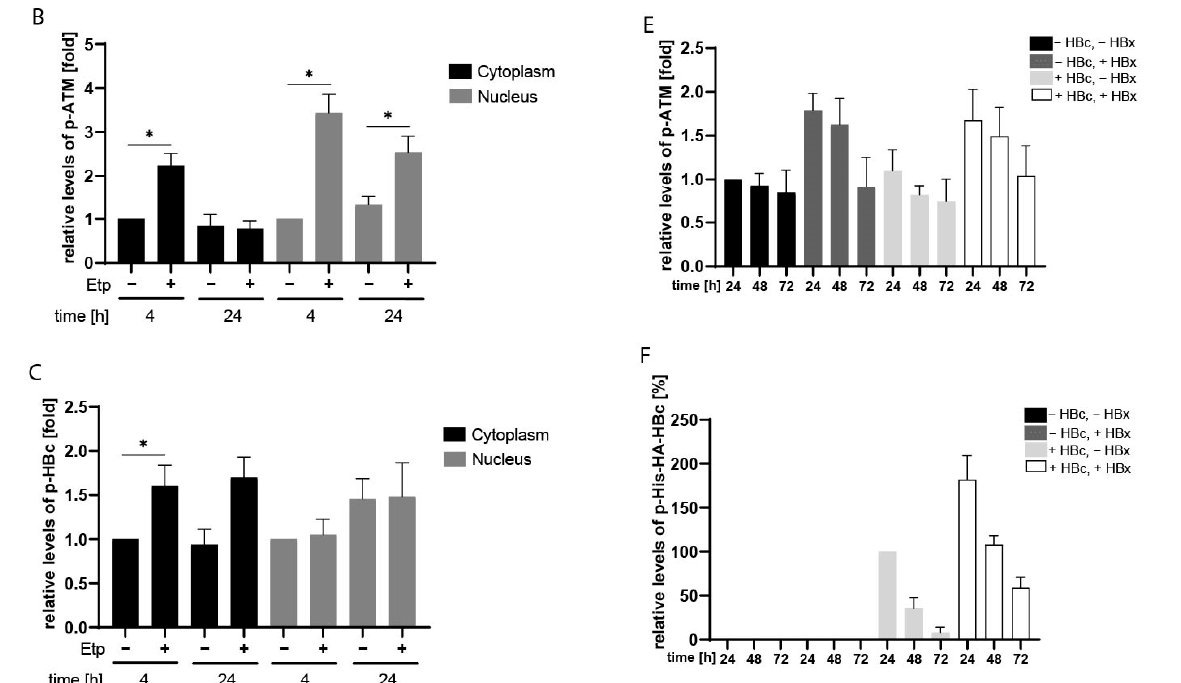
Figure 4. ( A ) Etoposide-induced phosphorylation of HBc occurs in the cytoplasm. The experimental outline: HepG2-NTCP cells were transfected with untagged HBc, followed by 1 h treatment with 100 μ M etoposide. 4 and 24 h after treatment, the cells were fractionated into cytoplasmic (left) and nuclear (right) extracts. The protein lysates (10 μ g) were analyzed by Western blotting with antibodies (from the top to the bottom) against a phospho-SQ motif (p-SQ), HBc, ATM, p-ATM, lamin A/C (nuclear marker), α -tubulin (cytoplasmic marker) and β -actin (loading control). The arrows indicate the expected position (21.5 kDa) of the HBc protein that is phosphorylated at the SQ sites (p-HBc). ( B , C ) The intensity of the ATM phosphorylation signal ( B ) and the HBc phosphorylation signal ( C ), that were determined in ( A ), were quantified using the Image Studio Lite software for densitometric analysis and normalized to the corresponding level of the total ATM or HBc expression. The levels of ATM or HBc phosphorylation in non-treated cells at a 4 h time-point were arbitrarily set to 1. The asterisks indicate statistically significant differences between the control (untreated) and Etp-treated groups determined by a two-tailed paired t test, * p < 0.05, n = 3. Error bars represent SD of three independent experiments. ( D ) The expression of HBx induced phosphorylation of HBc at the SQ sites. HepG2-NTCP cells were transfected with HBx, together with HBc expression plasmids, as indicated. The images display the cell lysates (20 µ g) that were isolated at different time-points post-transfection (24, 48 and 72 h), and analyzed by Western blot (marked as input) using antibodies (from the top to the bottom) against a phospho-SQ motif (p-SQ), HA (His-HA-HBc), HBx, ATM, p-ATM, ATR, p-ATR and β -actin (loading control). The arrow indicates the expected position of the 24 kDa His-HA-HBc protein (21.5 kDa of HBc plus 2.5 kDa of His-HA tag) that is phosphorylated at the SQ sites (p-His-HA-HBc). IP:anti-HA represents the cell lysates (800 µ g) that were precipitated with anti-HA antibodies (His-HA-HBc), and the precipitated complexes were analyzed by Western blot with an anti-p-SQ or anti-HA antibodies. The intensity of the HBc phosphorylation signal was quantified and normalized to the corresponding level of the total HBc expression. The level of HBc phosphorylation in the absence of the HBx expression at 24 h post-transfection was set to 100%. The p-His-HA-HBc values were calculated as mean of two independent experiments. ( E , F ) The densitometric analyses of the ATM phosphorylation signal (p-ATM; shown in ( E )) and the HBc phosphorylation signal (p-His-HA-HBc; shown in ( F )) that were determined in ( D ) using Image Studio Lite Software. The data are shown as mean ± SD from two independent